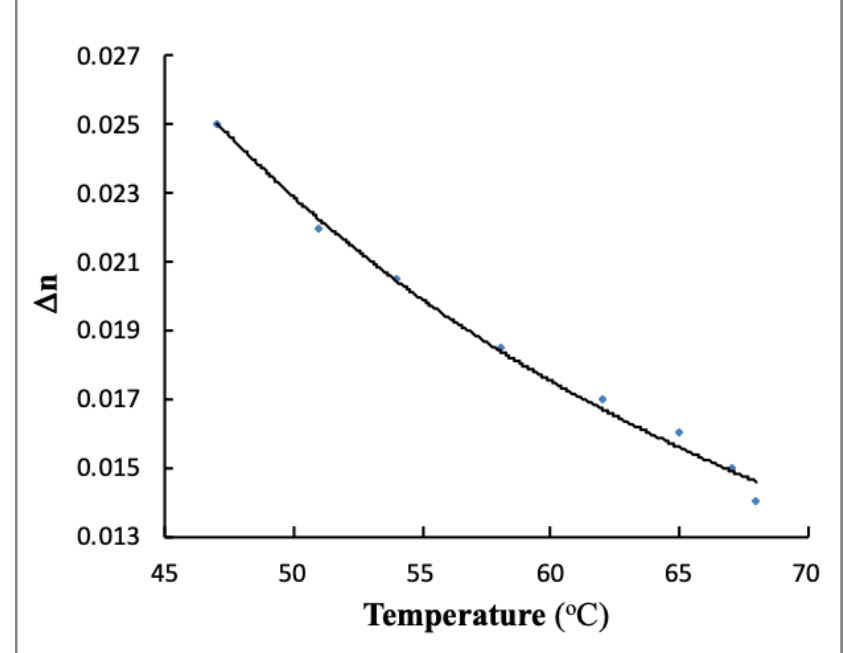
Figure 6. Temperature dependence of birefringence at 589.3 nm. The dots represent the measured birefringence ∆ n , and the solid line refers to the fitting using the relation of Cauchy dispersion.